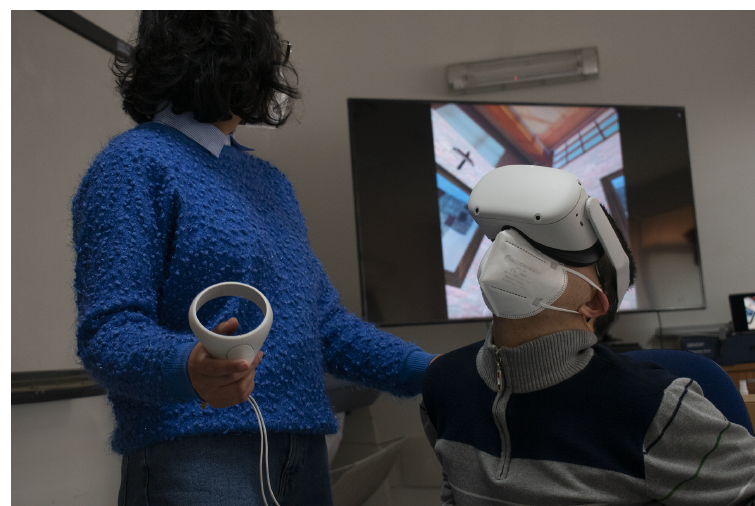
Figure 6. VR application